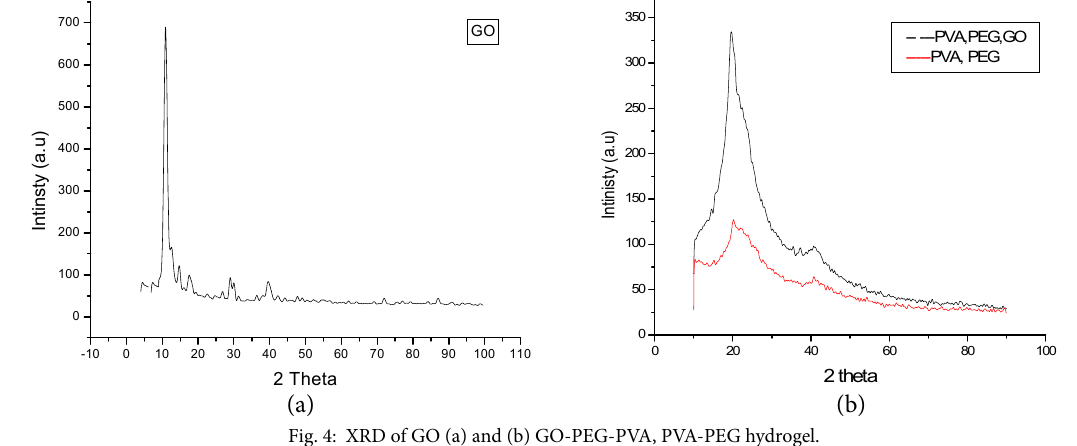
Fig. 4: XRD of GO (a) and (b) GO-PEG-PVA, PVA-PEG hydrogel.